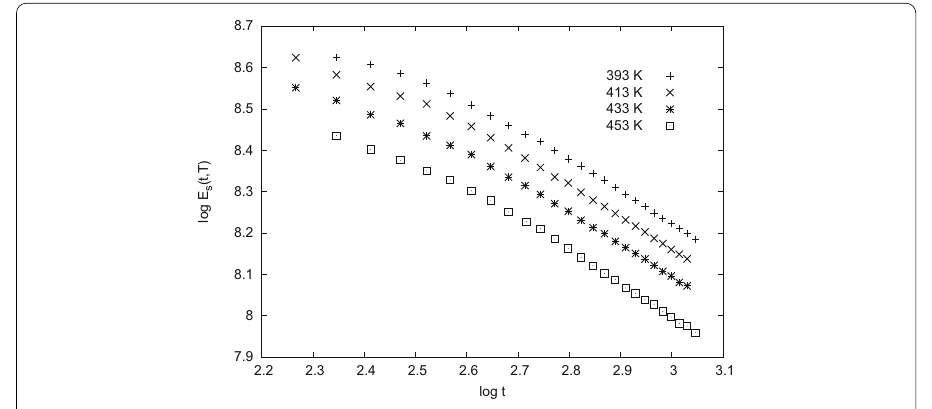
Fig. 2 Experimental secant modulus E s ( t,T ) vs time t (log-log representation) for PA66 at different temperatures, see Ref. [54]